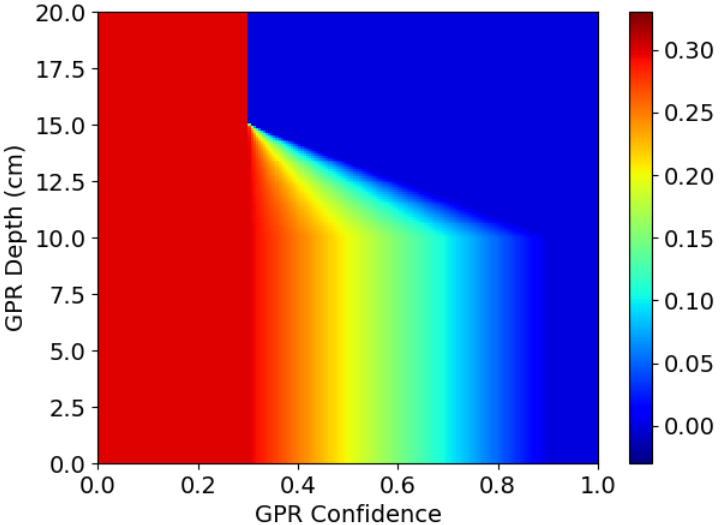
Figure 17. MIS detection threshold function as function of object depth (as reported by GPR) and GPR